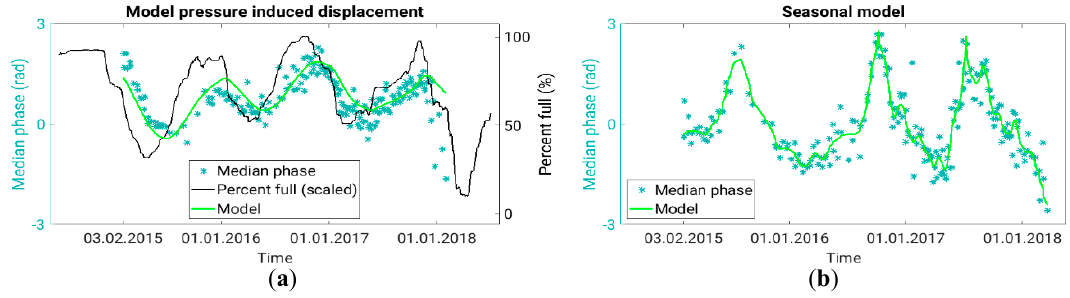
Figure 2. ( a ) Model for pressure response with combination of median time series of both orbits selected from preliminary InSAR results and average filling level f cavern as in equation (10); ( b ) Model for seasonal displacement together with combination of median time series of both orbits selected from preliminary InSAR results.